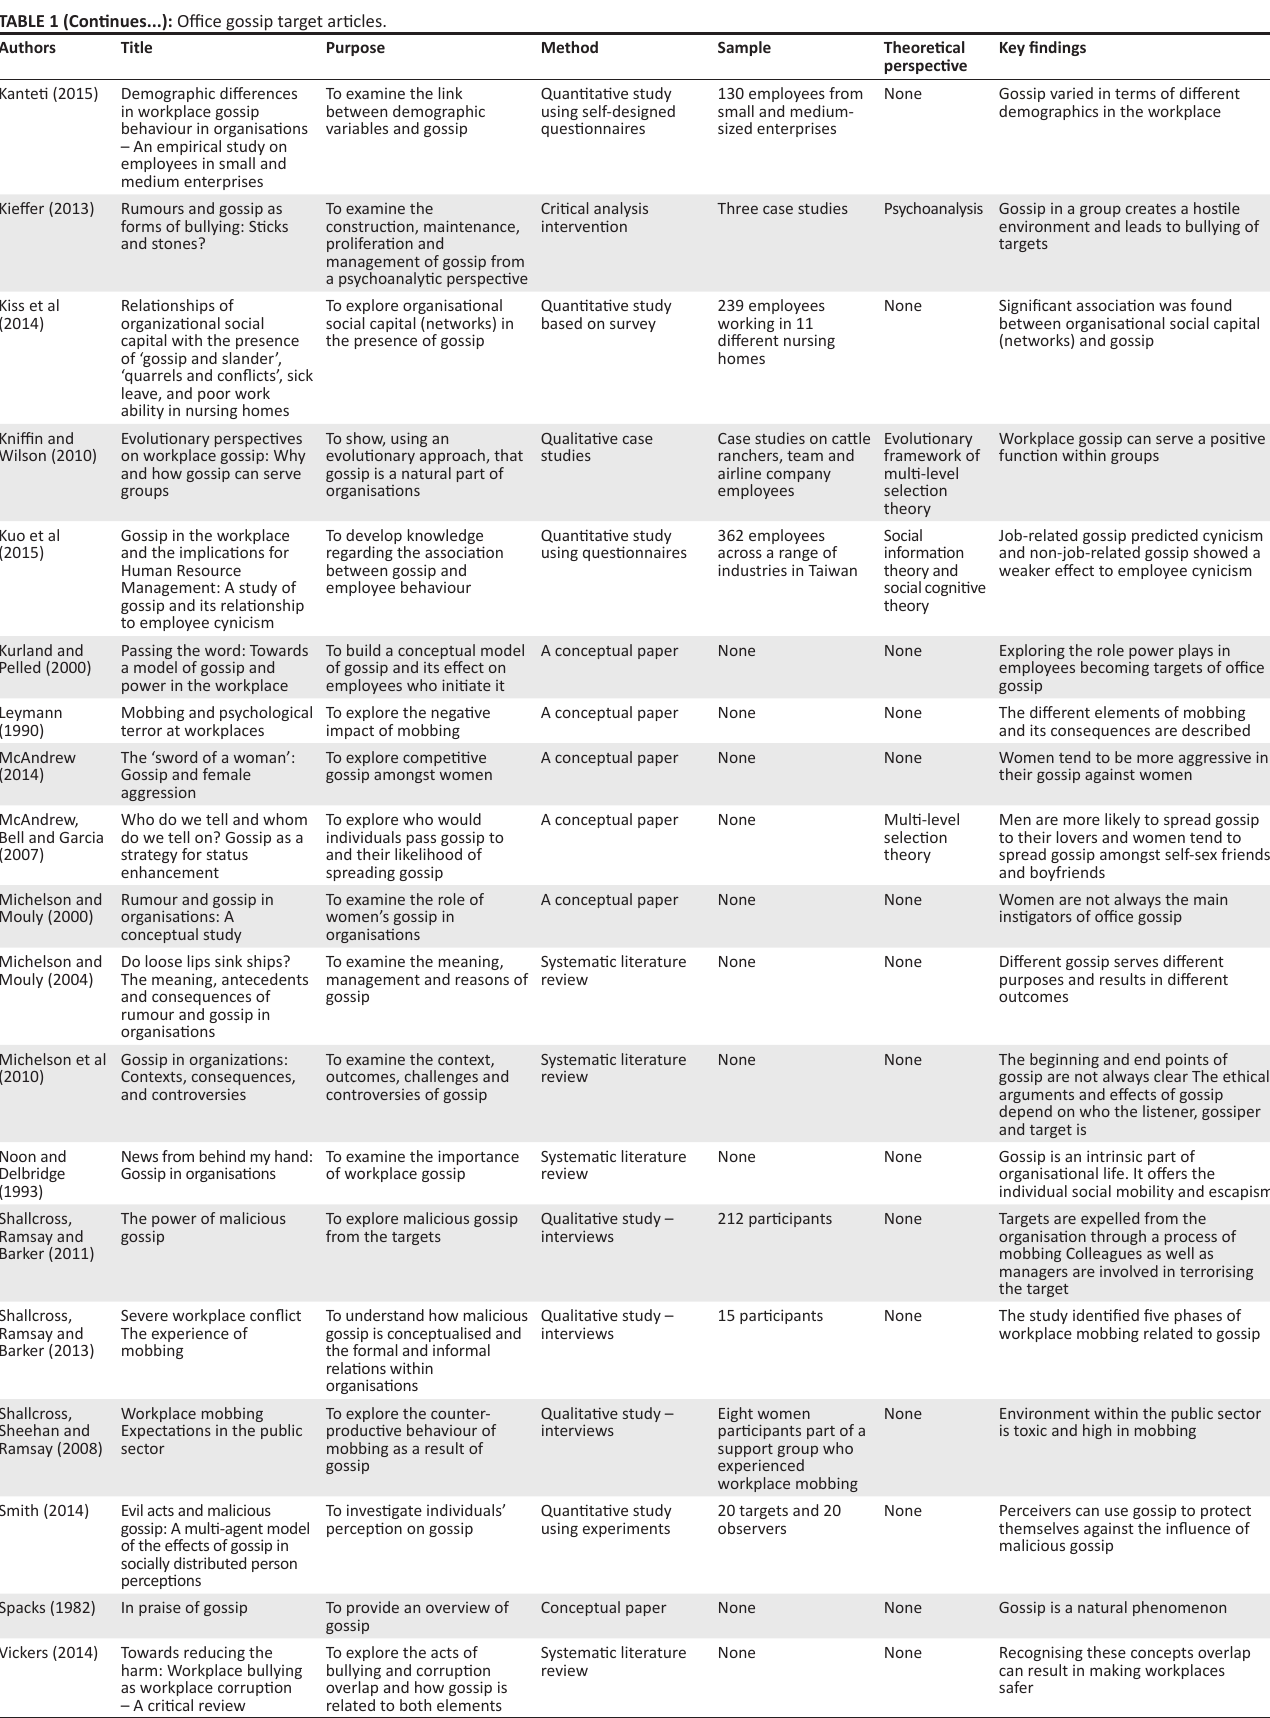
TABLE 1 (Continues...): Office gossip target